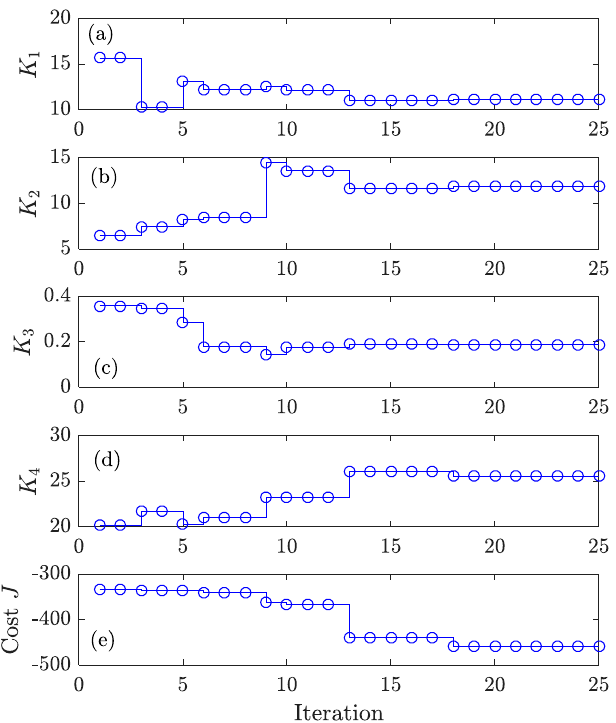
Figure 13. The global optimal solution and cost for each iteration. ( a ) K 1 vs. iteration number, ( b ) K 2 vs. iteration number, ( c ) K 3 vs. iteration number, ( d ) K 4 vs. iteration number, and ( e ) Cost function J vs. iteration number.